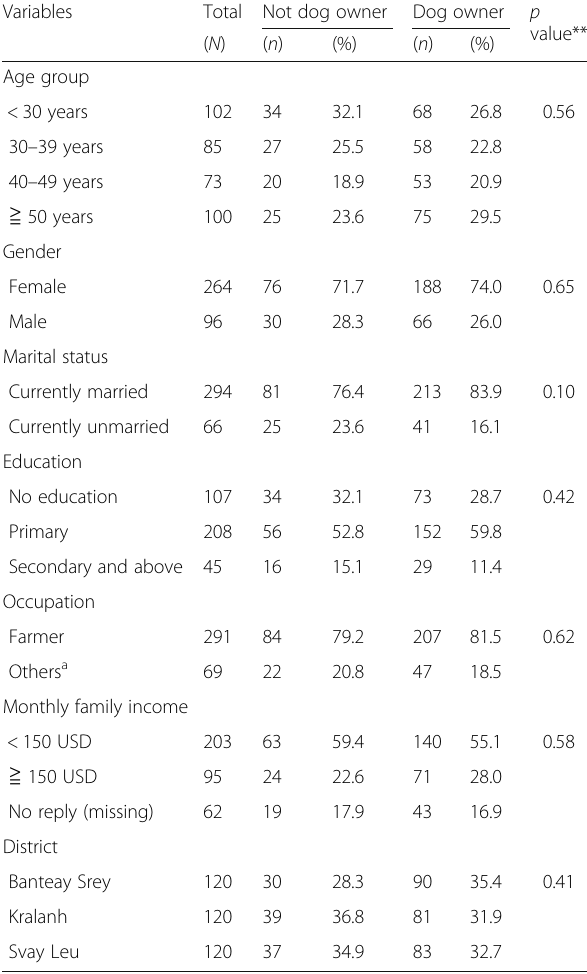
Table 2 Respondents ’ characteristics by dog ownership ( n